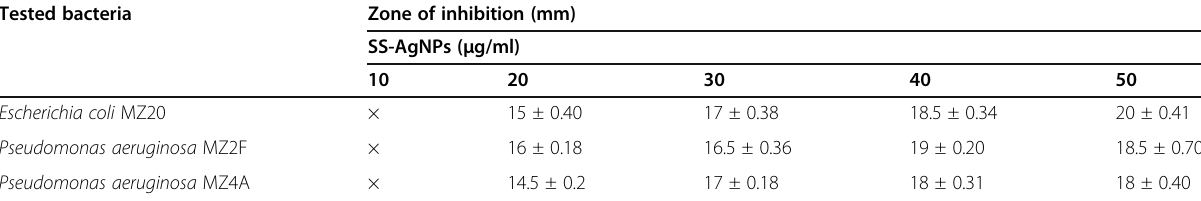
Table 3 Antibacterial activity of synthesized silk sericin-capped silver nanoparticles (SS-AgNPs) against multidrug-resistant Escerichia coli and Pseudomonas aeruginosa Tested bacteria Zone of inhibition (mm)